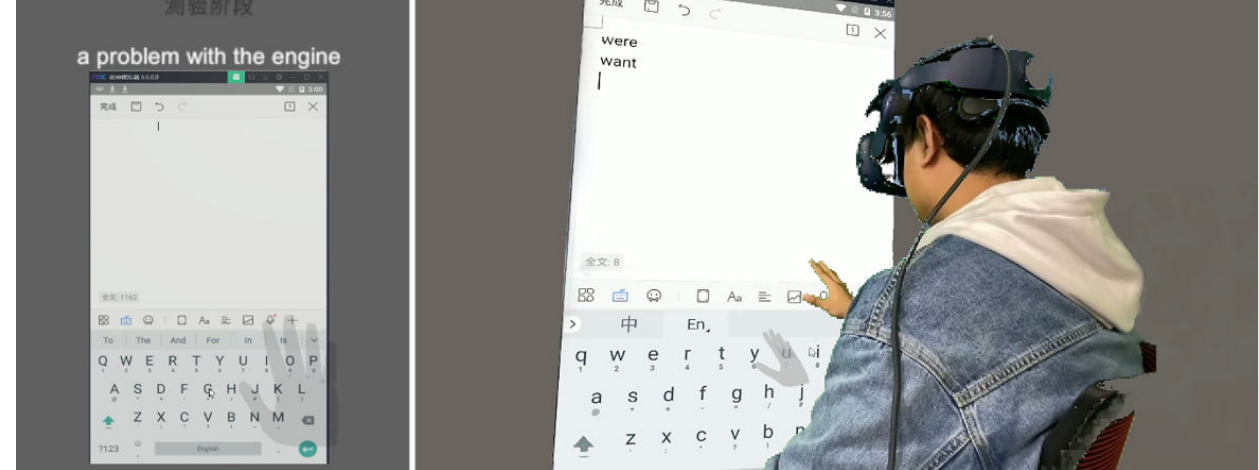
Figure 4. The virtual environment including stimulus, Android virtual machine user